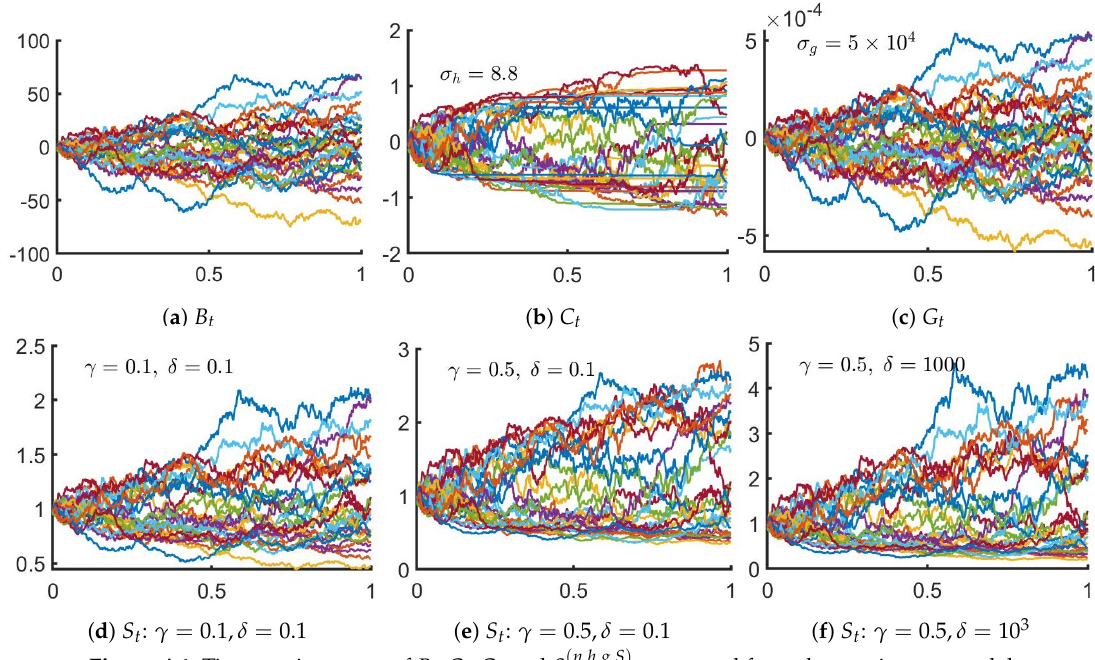
Figure A4. Times series traces of B t , C t , G t and S